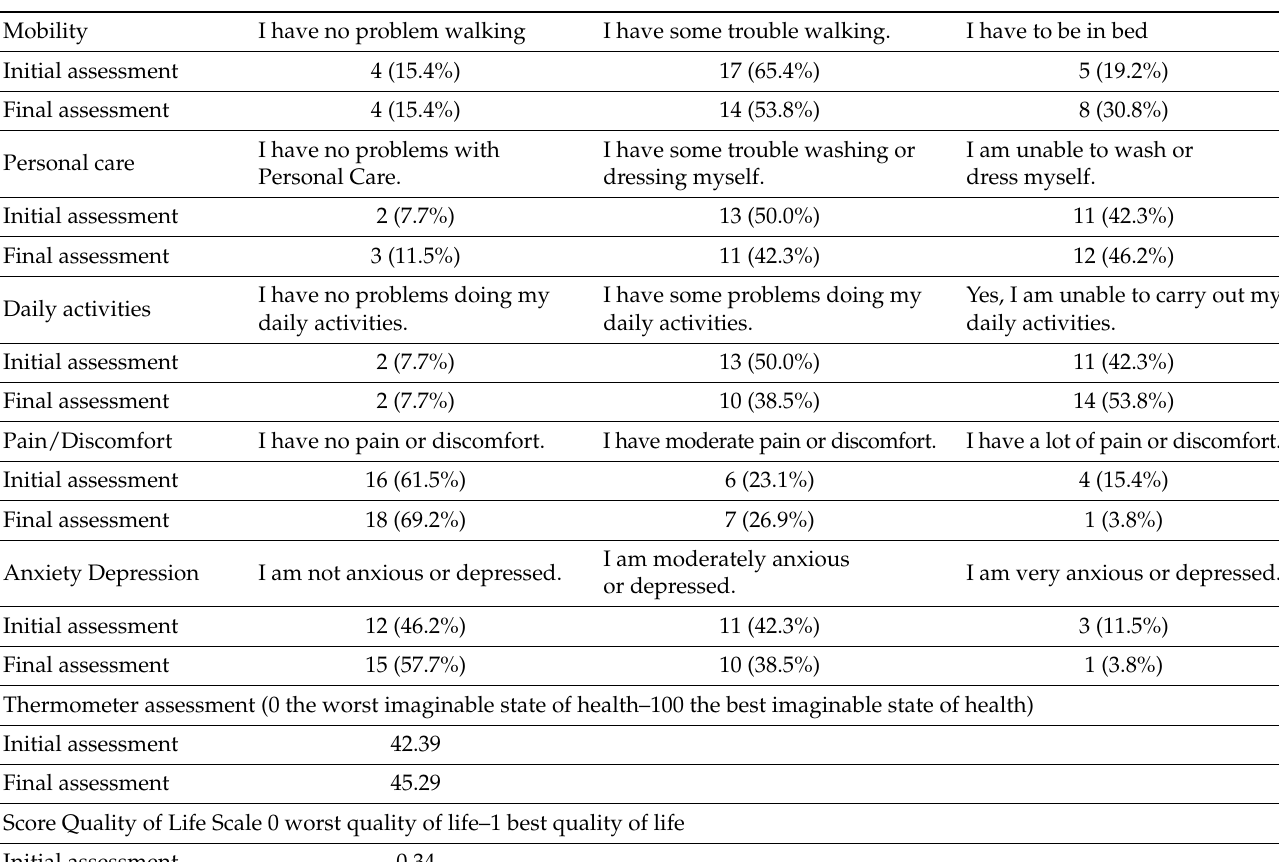
Table 6. Assessment of quality of life. Initial and final